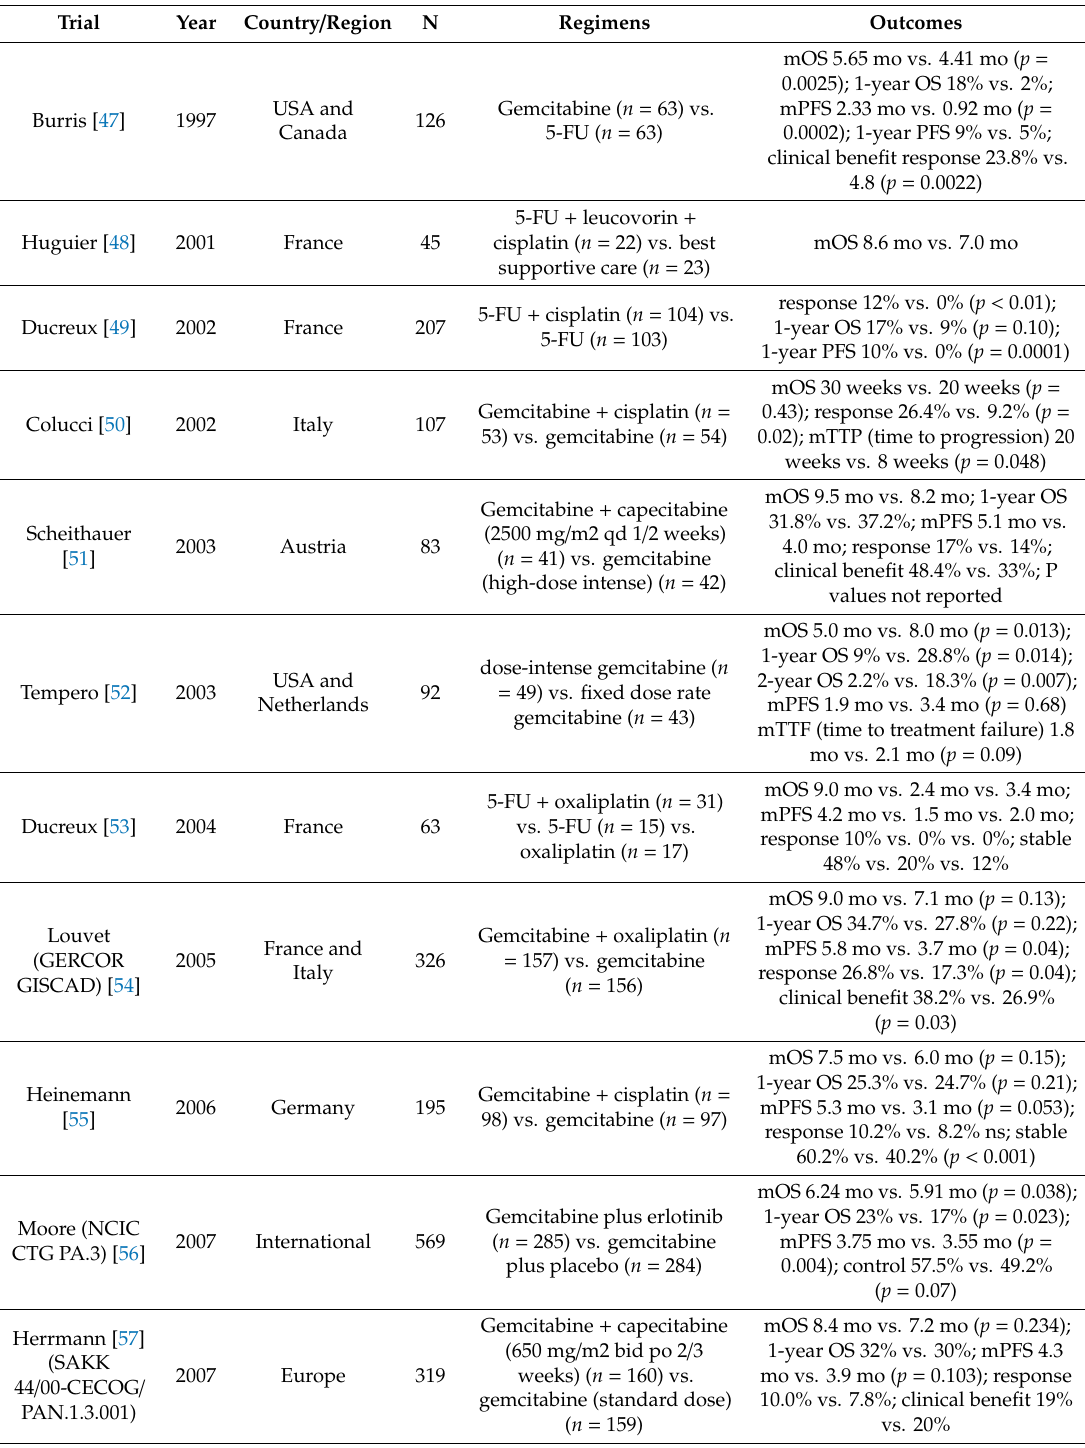
Table 3. Summary of randomized controlled trials concerning first-line chemotherapy in patients with locally advanced or metastatic pancreatic